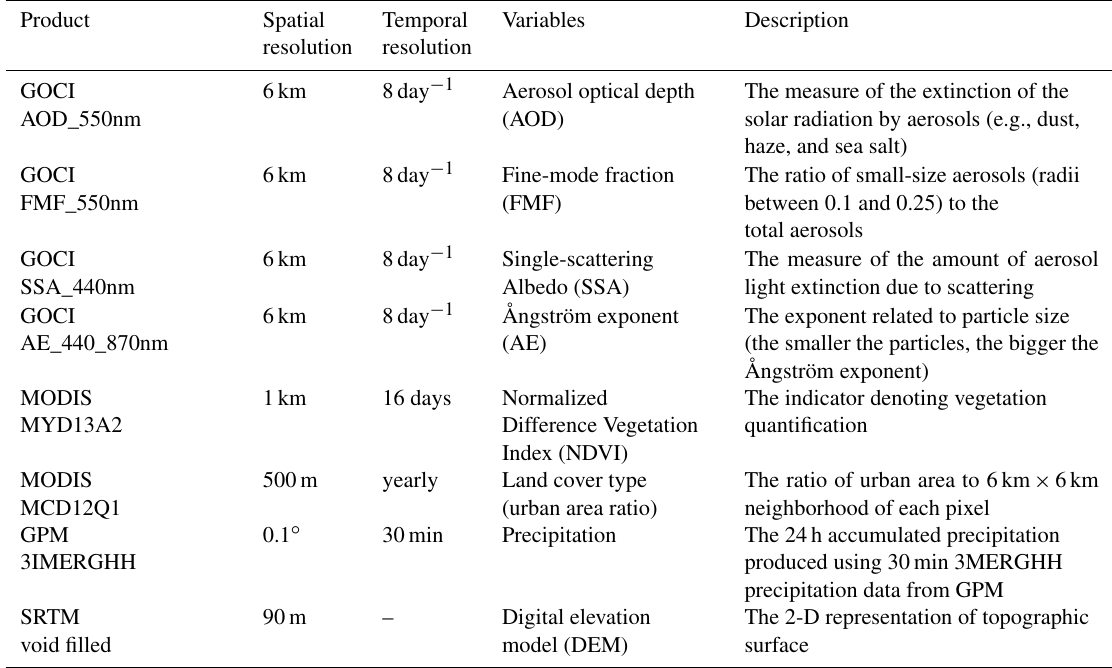
Table 1. Remote-sensing data used to develop models estimating ground-level particulate matter concentrations in this study. Product Spatial Temporal Variables Description resolution resolution GOCI 6km 8day − 1 Aerosol optical depth The measure of the extinction of the AOD_550nm (AOD) solar radiation by aerosols (e.g., dust, haze, and sea salt) GOCI 6km 8day − 1 Fine-mode fraction The ratio of small-size aerosols (radii (FMF) between 0.1 and 0.25) to the total aerosols 8day − 1 Single-scattering The measure of the amount of aerosol Albedo (SSA) light extinction due to scattering 8day − 1 Ångström exponent The exponent related to particle size (AE) (the smaller the particles, the bigger the Ångström exponent) The indicator denoting vegetation Normalized quantification Difference Vegetation Index (NDVI) The ratio of urban area to 6km × 6km (urban area ratio) neighborhood of each pixel The 24h accumulated precipitation produced using 30min 3MERGHH precipitation data from GPM Digital elevation The 2-D representation of topographic model (DEM)